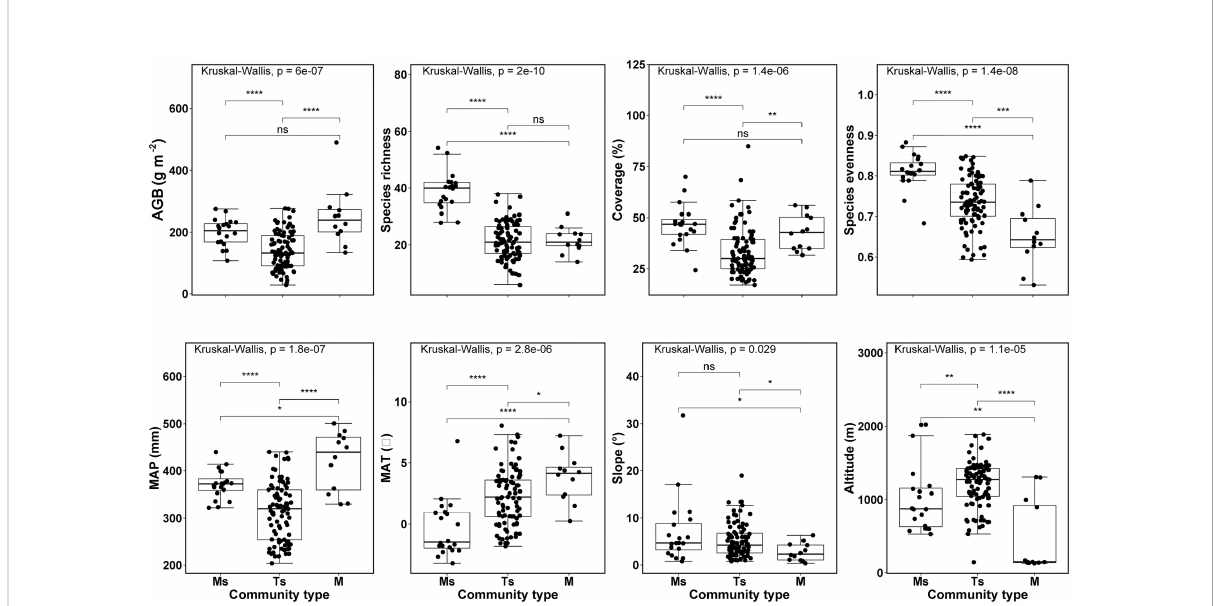
FIGURE 3 Differences for variables, used in the structural equation modelling, among three grassland community types dominated by Leymus chinensis in northern China. See Tables S1, S2 for the summary. MAP, mean annual precipitation; MAT, mean annual temperature; and AGB, aboveground biomass; Ms, meadow steppe; Ts, typical steppe; M, meadow. p:****and ***<0.001, **<0.01, *<0.05, and ns